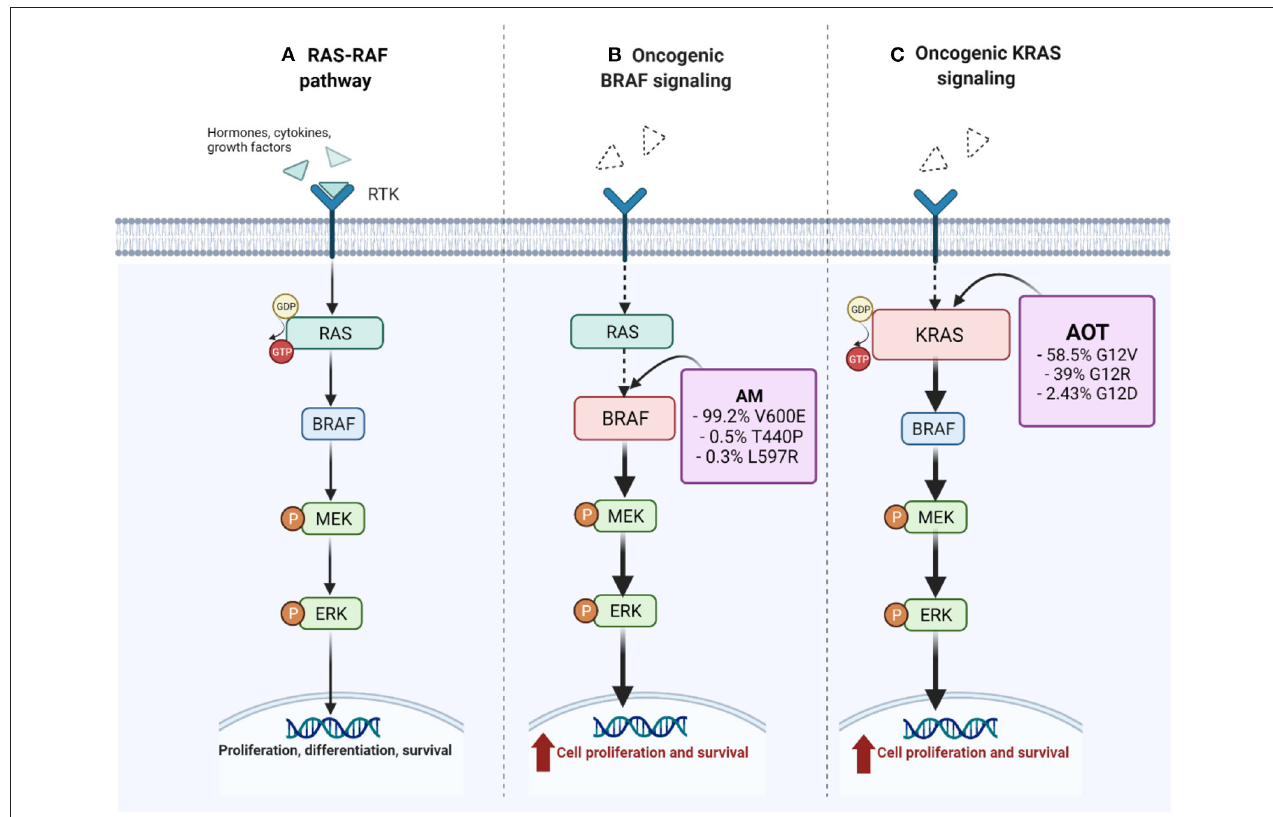
FIGURE 3 | Constitutive and oncogenic activation of MAPK/ERK pathway. In (A) , several growth factors, hormones, and cytokines activate the receptor tyrosine-kinase (RTK) favoring the constitutive activation of RAS by switching GDP-GTP toward the activate state. The downstream signaling is regulated by RAS-GTP and additional proteins that are not shown in this figure. Ras activates BRAF which facilitates the phosphorylation of MEK, which in turn allows the phosphorylation and activation of ERK. The resulting signaling cascade culminates with translocation of ERK to the nucleus, and the activation of transcription factors that result in the expression of genes related to proliferation, differentiation, and survival. In (B,C) , in the presence of oncogenic BRAF and KRAS, respectively, the constitutive activation is independent of extracellular factors and does not respond to biochemical signals that would normally regulate the activity. Adapted from “Vemurafenib in Oncogenic BRAF Signaling Pathway in Melanoma,” by BioRender.com (2021). Retrieved from: